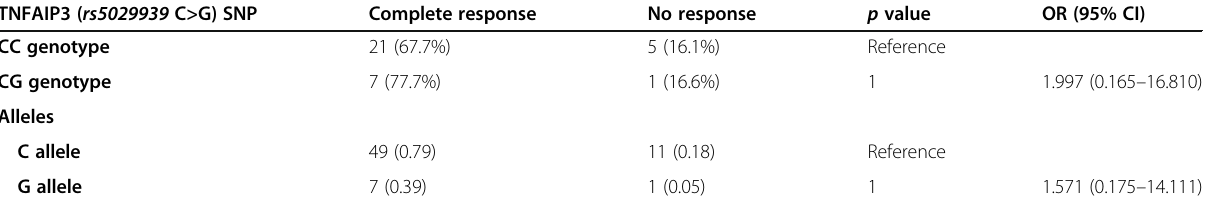
Table 5 The impact of TNFAIP3 ( rs5029939 C>G) SNP on the laboratory response to treatment in chronic PIT patients TNFAIP3 ( rs5029939 C>G)